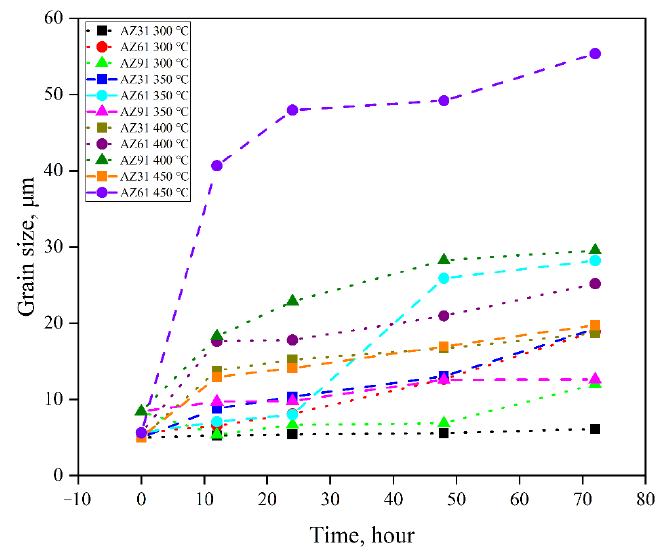
Figure 8. The average grain size of Mg–xAl–1Zn (x = 3, 6, 9) alloys at different annealing conditions.